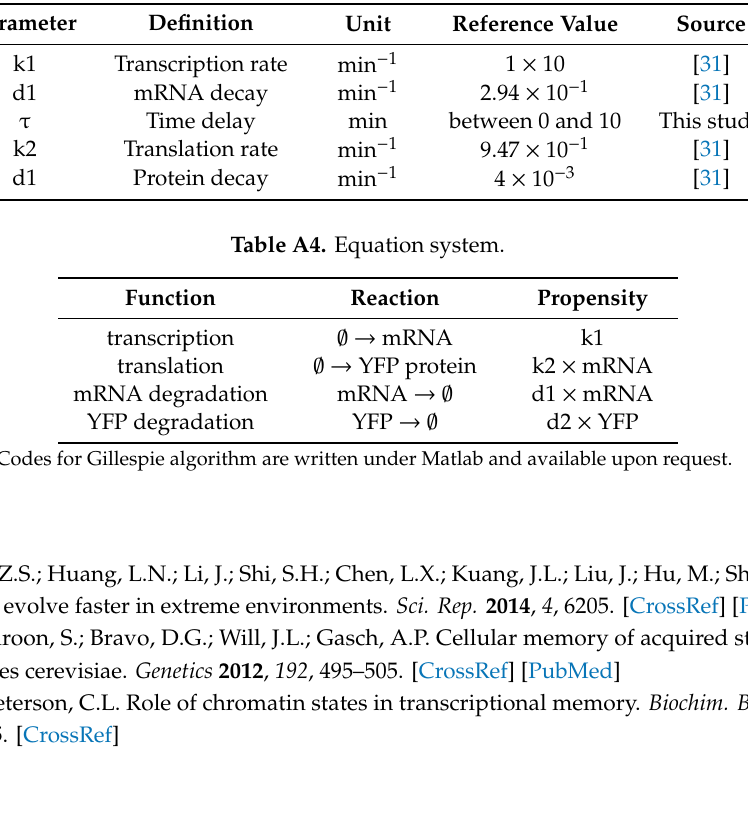
Table A3. Gillespie parameters.